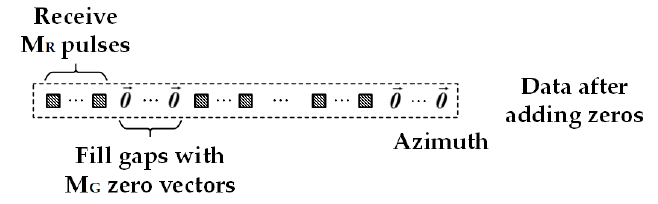
Figure 6. Demonstration of filling gaps with zeros.